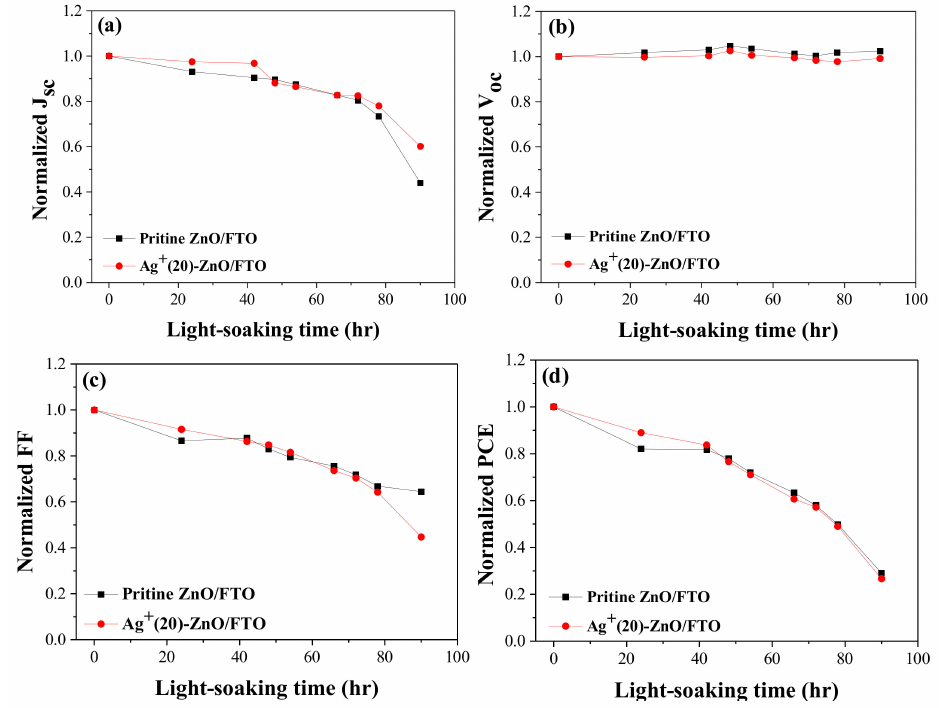
Figure 9. Light-soaking stability; ( a ) J sc , ( b ) V oc , ( c ) FF , and ( d ) PCE of DSCs with the pristine ZnO/FTO and Ag + (20)–ZnO/FTO. Photovoltaic parameters were measured under illumination (AM 1.5